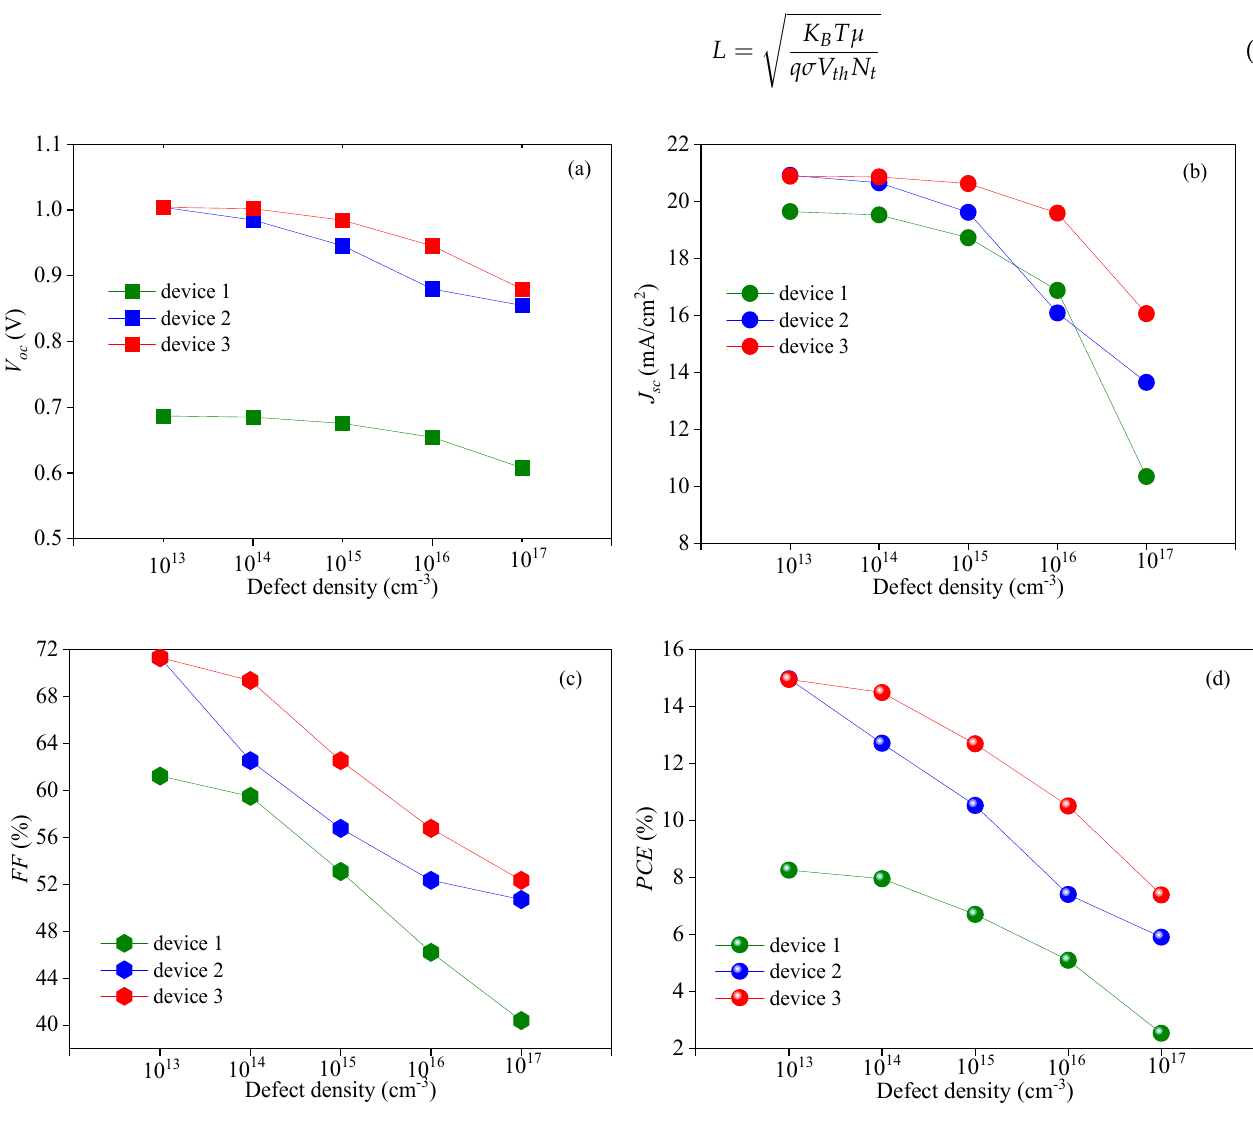
Figure 10. Effect of Nt on the J–V characteristic curve: ( a ) effect of N t on J-V characteristic curve of device 1, ( b ) effect of N t on J-V characteristic curve of device 2, and ( c ) effect of N t on J-V characteristic curve of device 3.